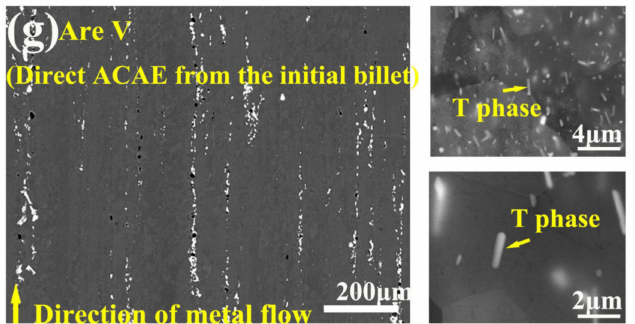
Figure A1. High resolution of Figure 4: ( a ) initial billet; ( b ) billet deformed by UE; ( c ) UE + ACAE Zone II; ( d ) UE + ACAE Zone III; ( e ) UE + ACAE Zone IV; ( f ) UE + ACAE Zone V; ( g ) ACAE Zone